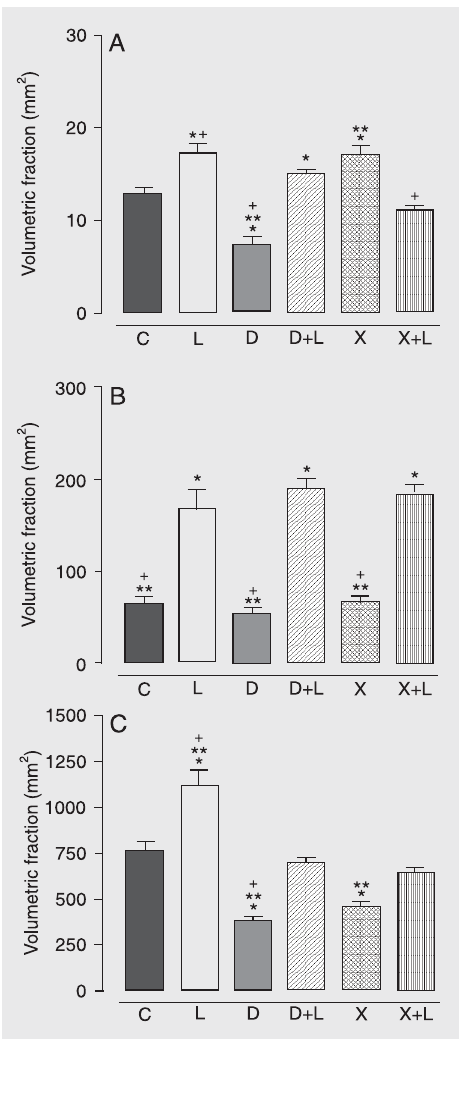
0.1 mm at 20x 0.1 mm at